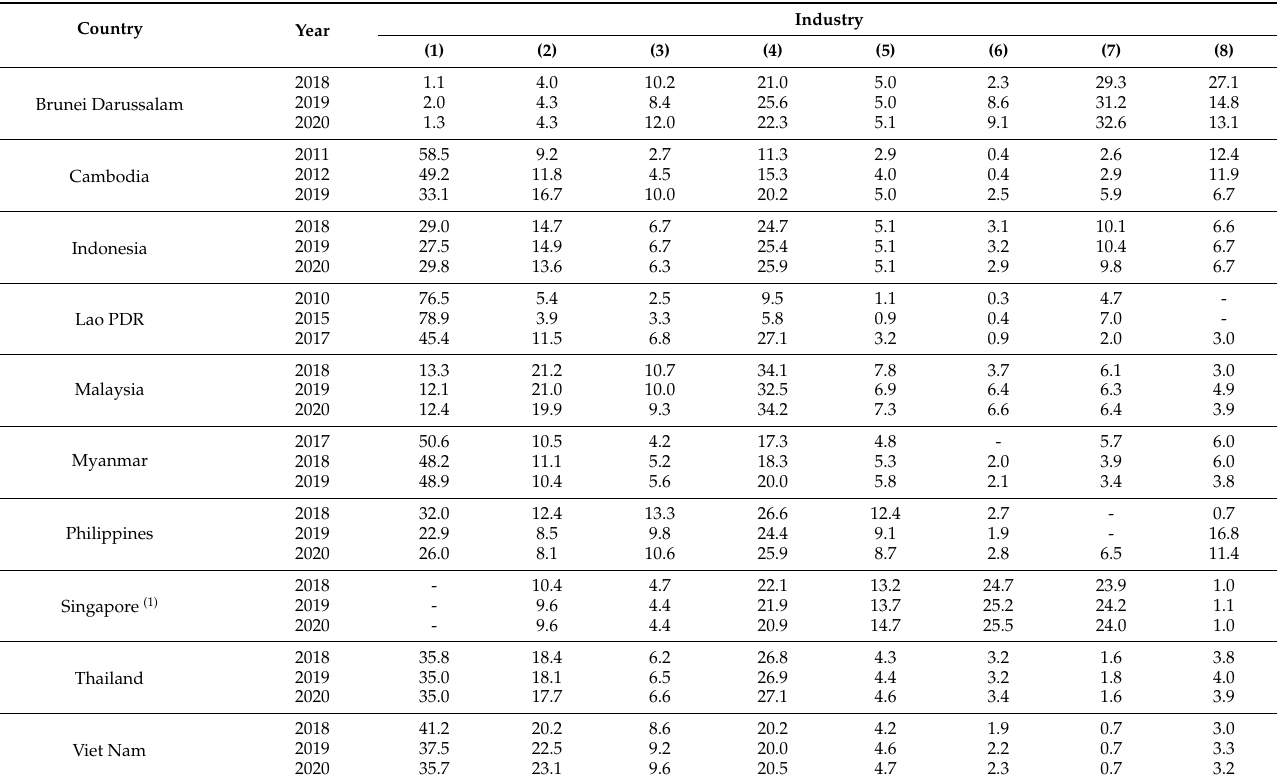
Table 2. Proportion of Employment in ASEAN by Economic Activity (in per